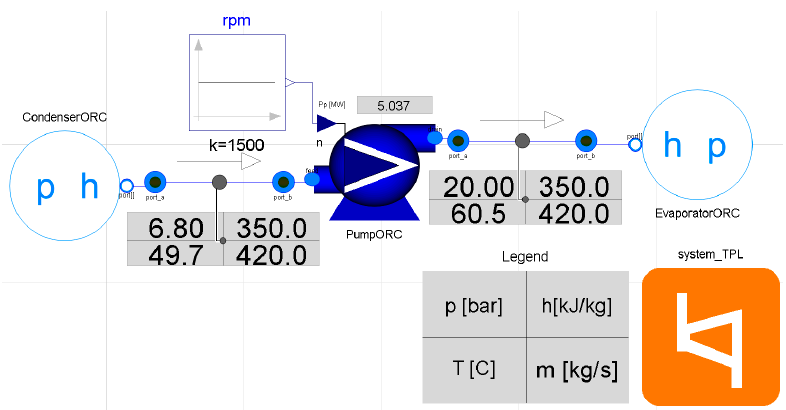
Figure 13. The model of the ORC feed pump with working medium R-600a.